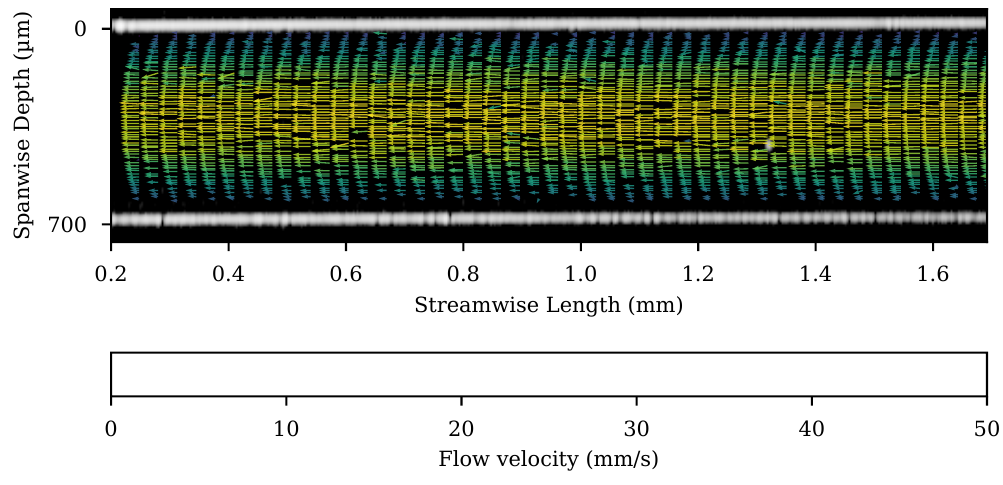
Figure 7. A flow velocity map is shown superimposed on a single OCT image frame from the straight section of the channel. The whole channel is shown with every third streamwise bin plotted for clarity. The bins are 10µm square. The length of the velocity vector is additionally indicated by the colour bar. Missing arrows represent empty